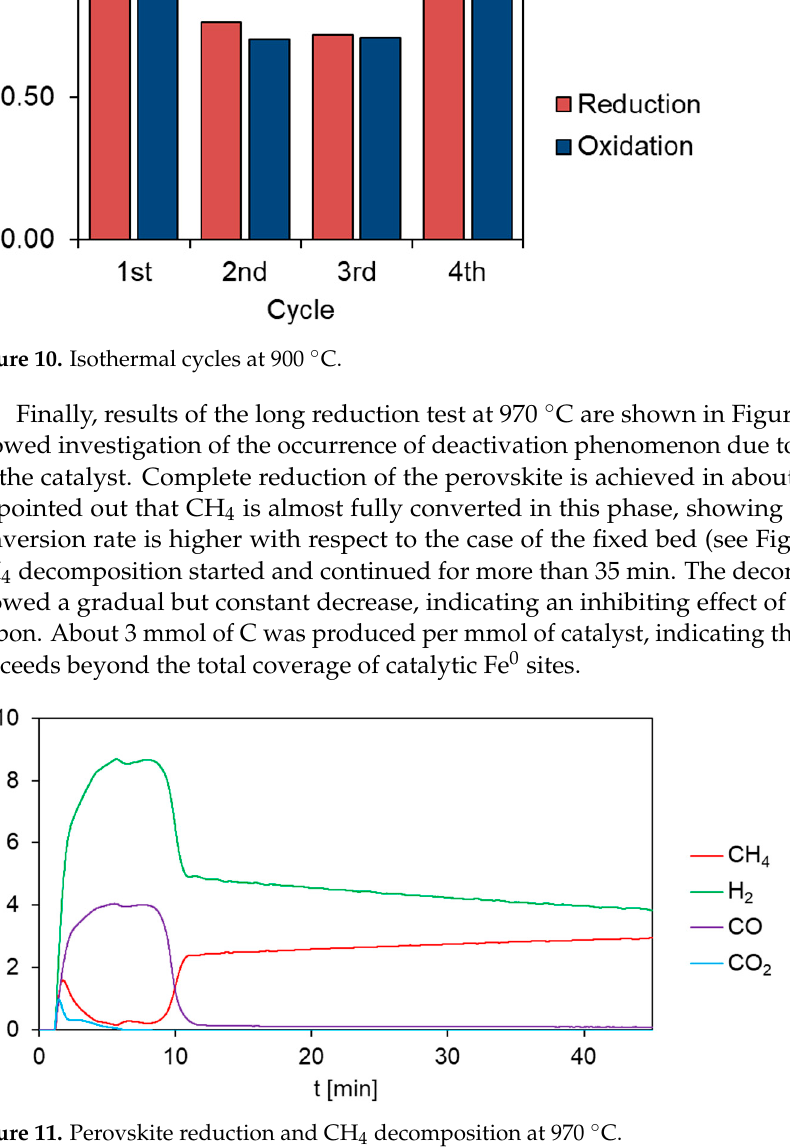
Figure 9. Isothermal cycles at 900 °C: reduction step ( a ), oxidation step ( b ), 2nd cycle (dashed line), 4th cycle (continuous line).